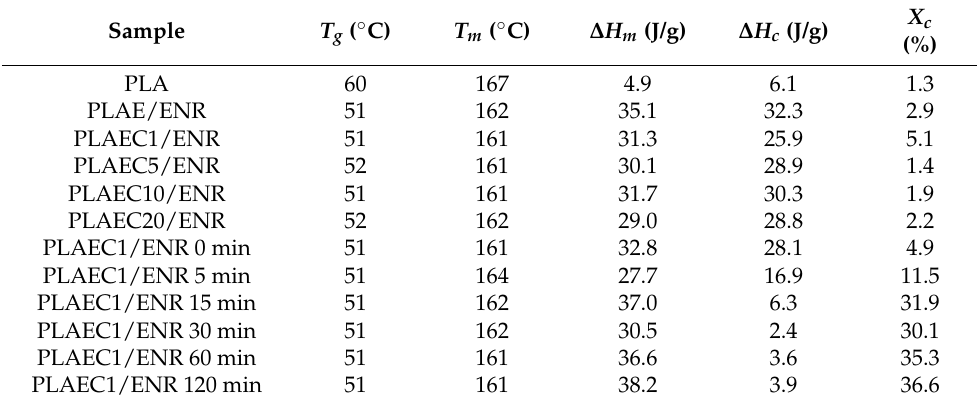
Figure 7. DSC curves of ( a ) second scan of PLA, PLAE/ENR, and PLAEC/ENR with 1–20% CTS and ( b ) first scan of PLAEC1/ENR with annealing (0–120 min) at 80 ◦ C. Table 3. Second scan DSC results of PLA, PLAE/ENR, and PLAEC/ENR blend with 1–20% CTS, and first scan DSC results of PLAEC1/ENR after annealing (0–120 min) at 80 ◦